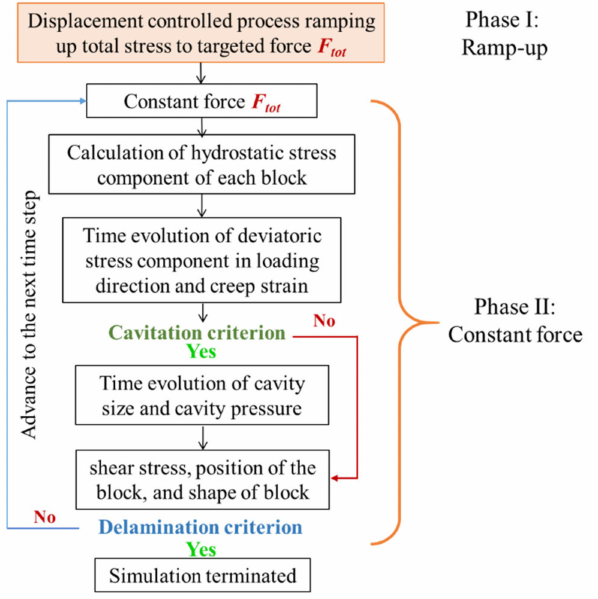
Figure 10. Modeling algorithm for creep of single-layered joint, showing flowchart for both phases of the creep test.